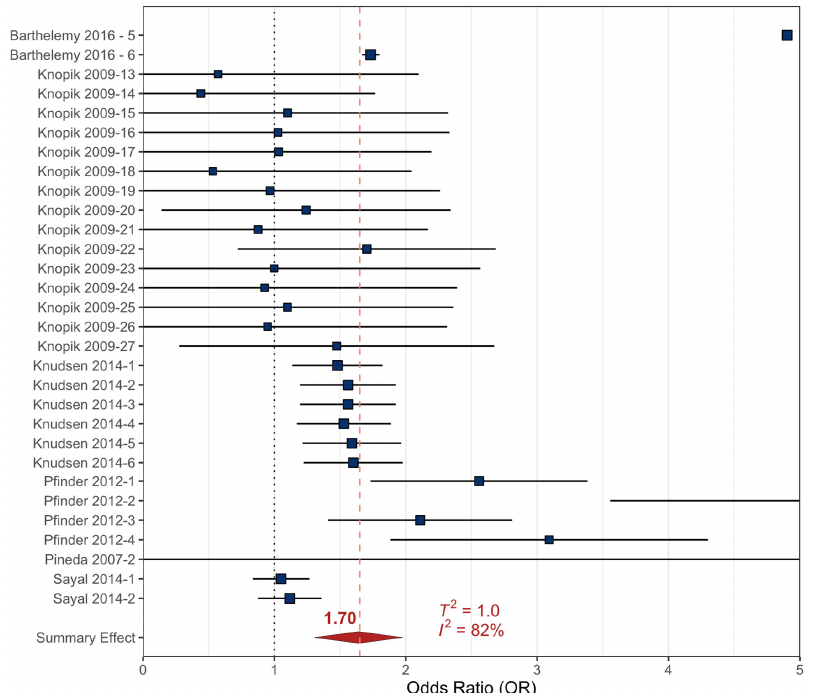
Figure 4. Forest plot showing the externalizing behavioral health outcomes included in the random effects meta-analysis for prenatal exposure to alcohol. The squares represent the mean OR from each reference dataset (Table S4), horizontal error bars represent the upper and lower 90% CI, the size variation of the boxes represents the weight each dataset had in the meta-analysis with a larger size indicating larger weights. The diamond and dashed line represent the summary effect OR based on the meta-analysis. The ‘line of no effect’ at an OR of 1 is indicated with a dotted line.